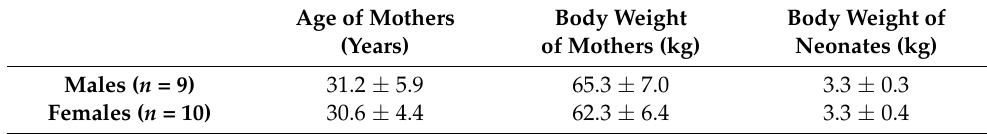
Table 1. Physical data of the enrolled cohorts.